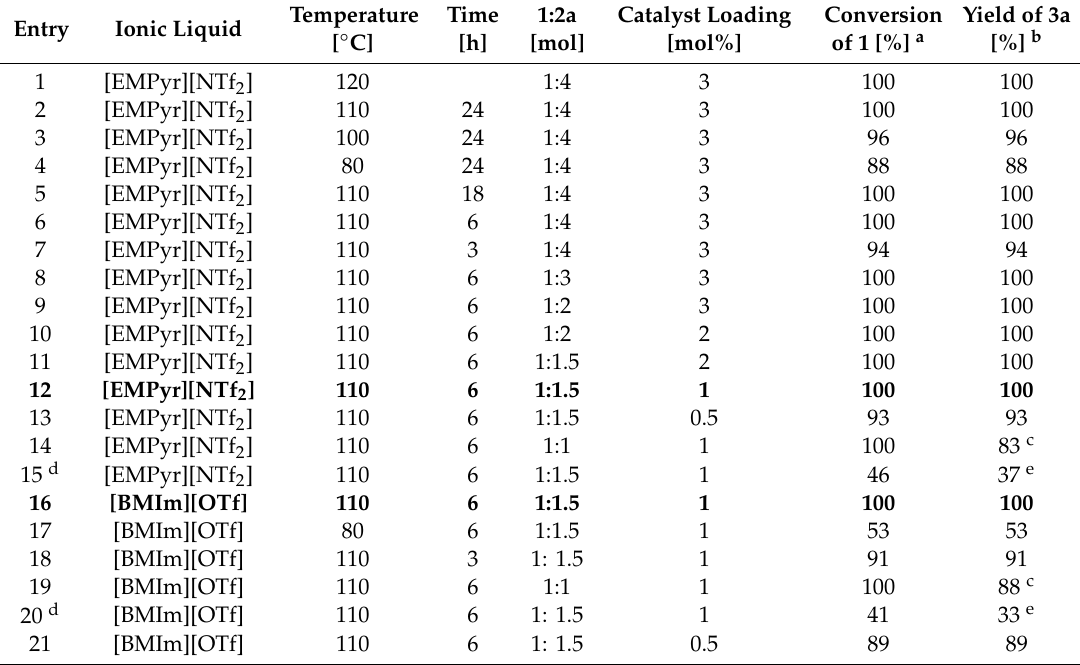
Table 2. Reaction conditions screening for borylative coupling of 1 with 2a in the presence of